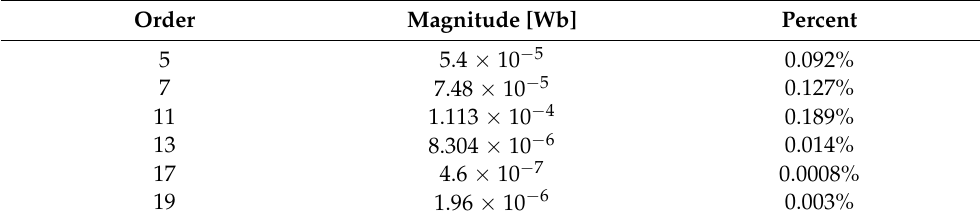
Table 4. Harmonics of each order of flux linkage and their ratio to the fundamental wave. Order